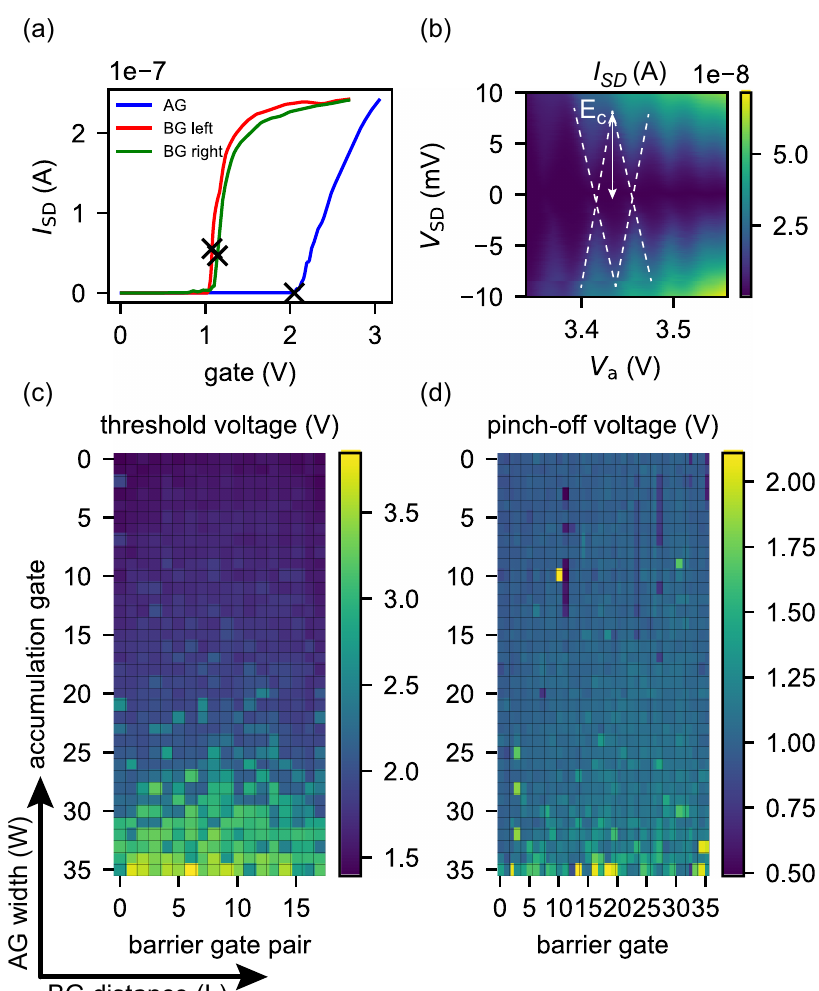
Fig. 2 Crossbar electrical characterization. a Source-drain current I SD through a selected fi eld effect transistor measured at T = 1.7 K as a function of accumulation gate voltage V a with fi xed barrier voltages V b = 2.7 V (blue line). The turn on threshold voltage V to is indicated with a black cross. The same transistor is measured as a function of V b,left and V b,right at 1 V above V to (red and green lines), with black crosses indicating pinch-off voltages V po . b I SD as a function of source-drain bias V SD and V a with fi xed V b measured at T = 1.7 K. In the single electron transport regime, Coulomb diamonds are observed (dashed white lines) from which the charging energy E C = 8 meV and the lever arm α = 0.2 eV/V can be extracted. Color-scale maps of all measured V to ( c ) and V po ( d ) in a grid of varying quantum dot widths W and lengths L as a function of location within the grid, where each box represents an FET unit cell in the array. Each box in d is split in two to indicate both V po,left and V po,right